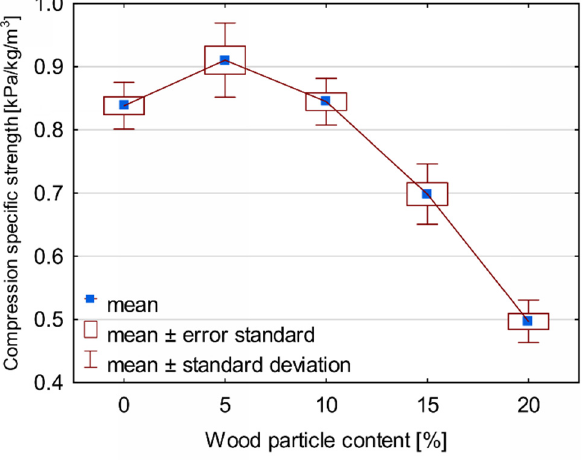
Figure 12. Compression specific strength of PUR-WP composition depending on wood particle con- tent.